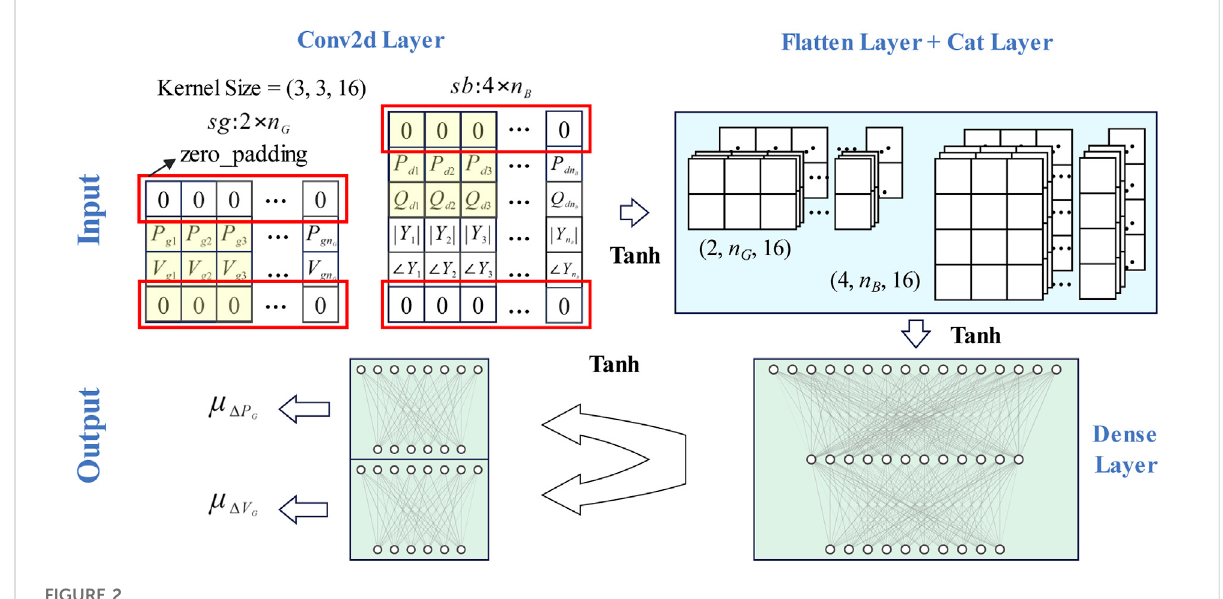
FIGURE 2 Network